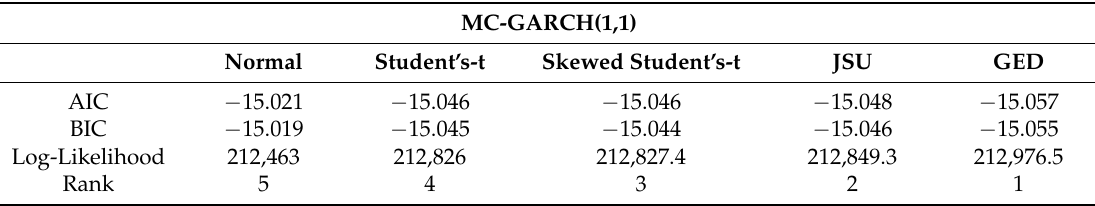
Table 4. Model selection for the MC-GARCH(1,1) model.